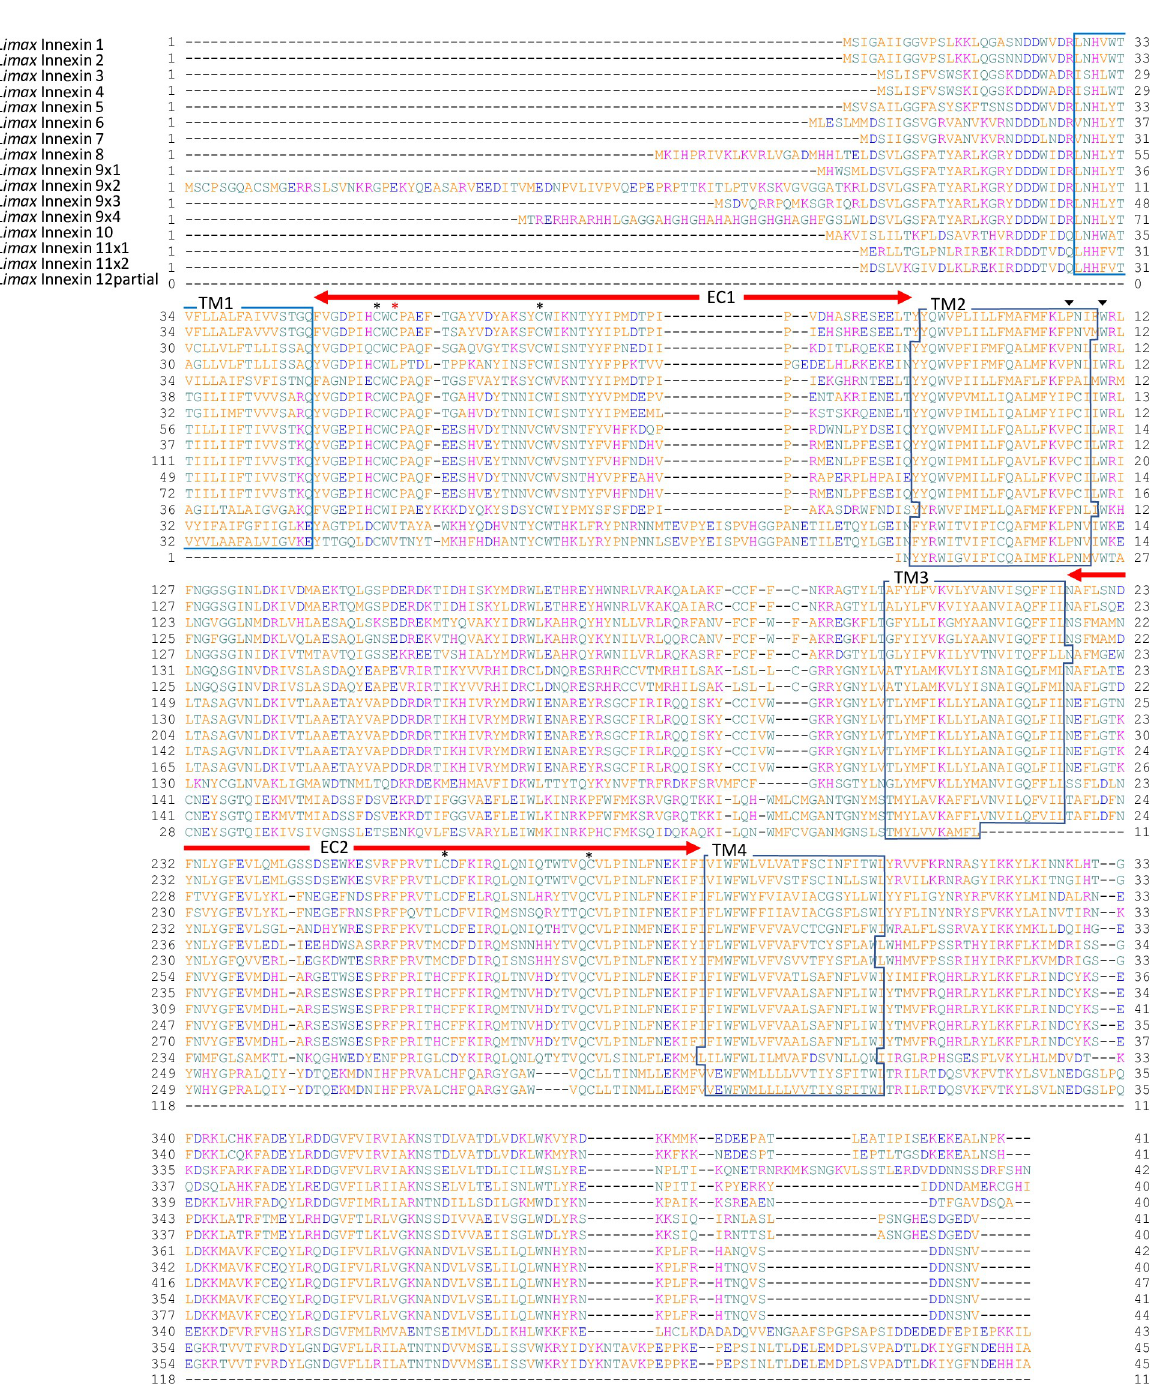
PLOS ONE | https://doi.org/10.1371/journal.pone.0244902 April 15,